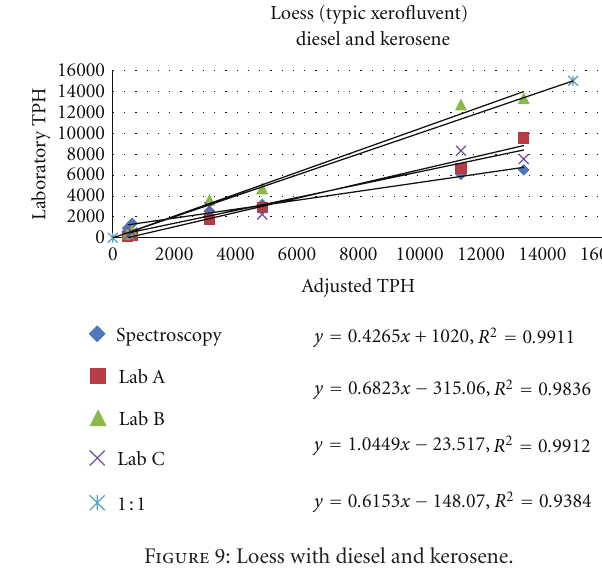
Figure 7: Gromosol with all PHC types.